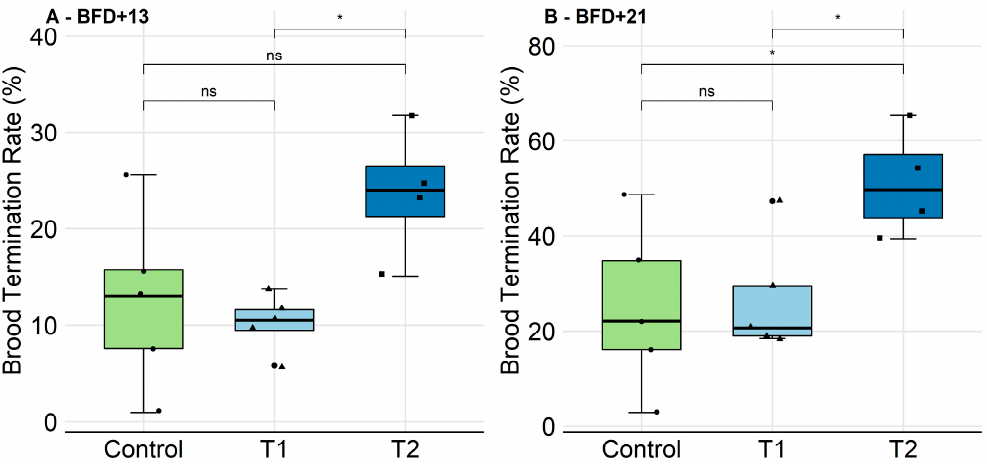
Figure 3. Effect of chronic GBH feeding exposure (T1: 4.8, T2: 137.6 mg a.i./kg) on the Brood Termination Rate (BTR; see Supplementary Material Method S1), displayed as a boxplot. ( A ) The BTR on BFD + 13 (Brood area Fixing Day). ( B ) Eight days later, on BFD + 21, T1 did not show di ff erences when compared to the control ( p > 0.05, t -test, pairwise). T2, however, revealed a significantly higher BTR ( p < 0.05, t -test,